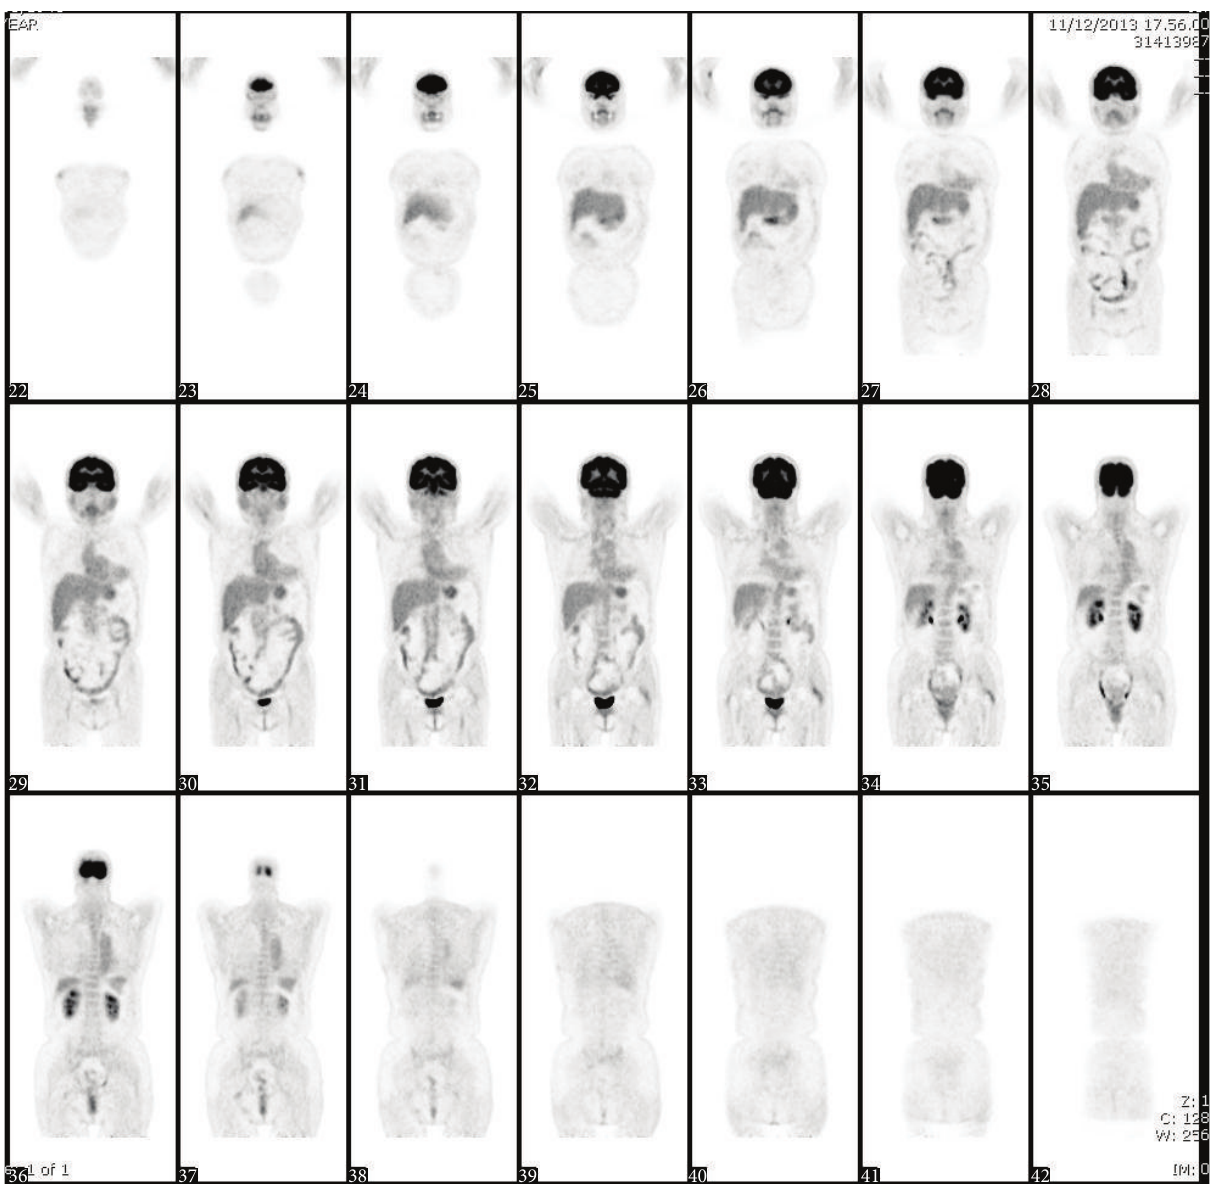
Figure 2: Positron emission tomography 3 months after the initiation of cyclophosphamide and steroids